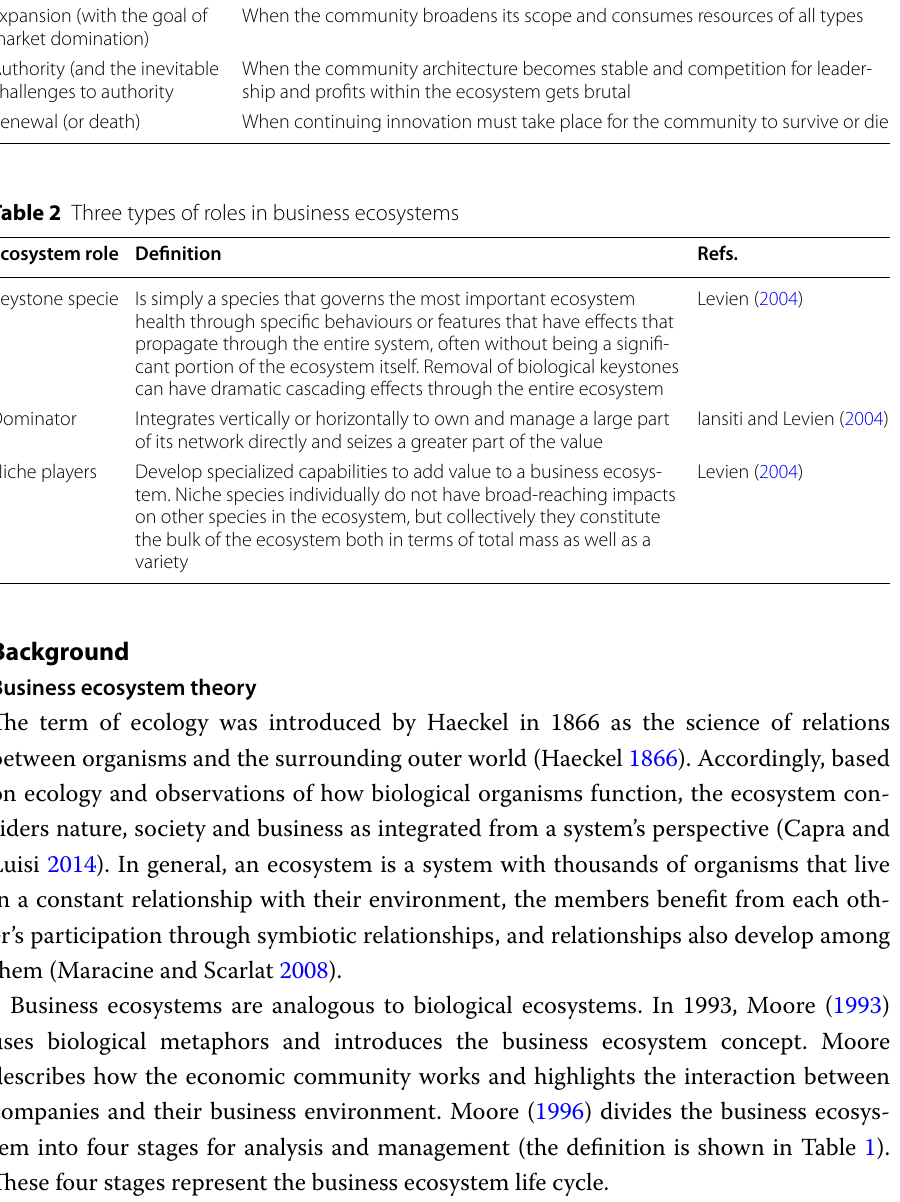
Table 1 Business ecosystem life cycle by Moore (1996) Stage Definition Pioneering (Vision) Expansion (with the goal of market domination)